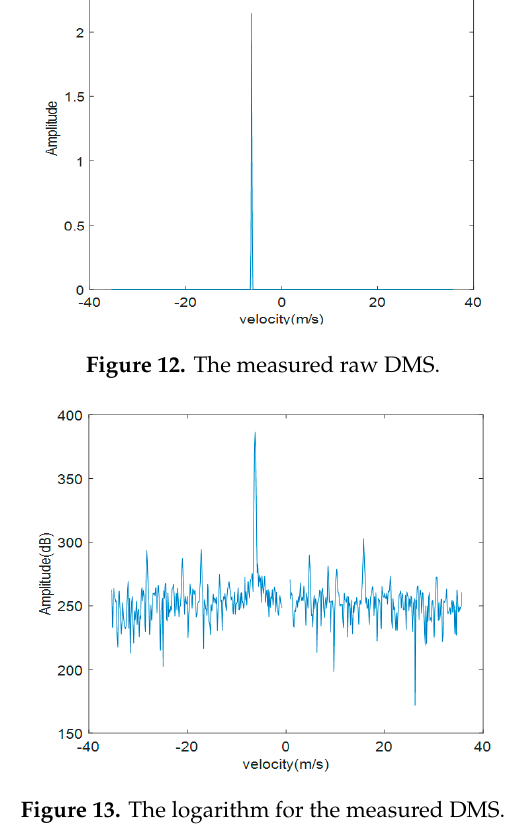
Figure 13. The logarithm for the measured DMS.